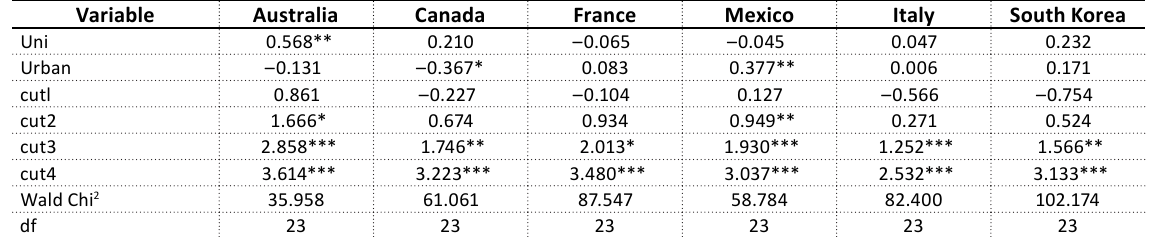
Table B6 (cont.). Countrvwise parameter estimates of ordered probit with random